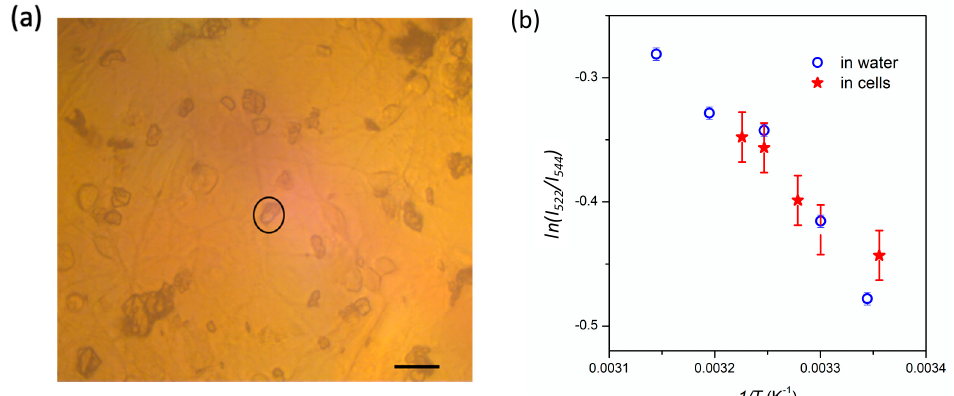
Figure 5. ( a ) Optical image of Yb 3+ ,Er 3+ -doped α -La(IO 3 ) 3 nanocrystals loaded onto neuronal cells with a concentration of 0.1 mg/mL, in water (Scale bar: 12 µ m). ( b ) Evolution of LIR of the nanocrystals adsorbed on neurons as a function of temperature.